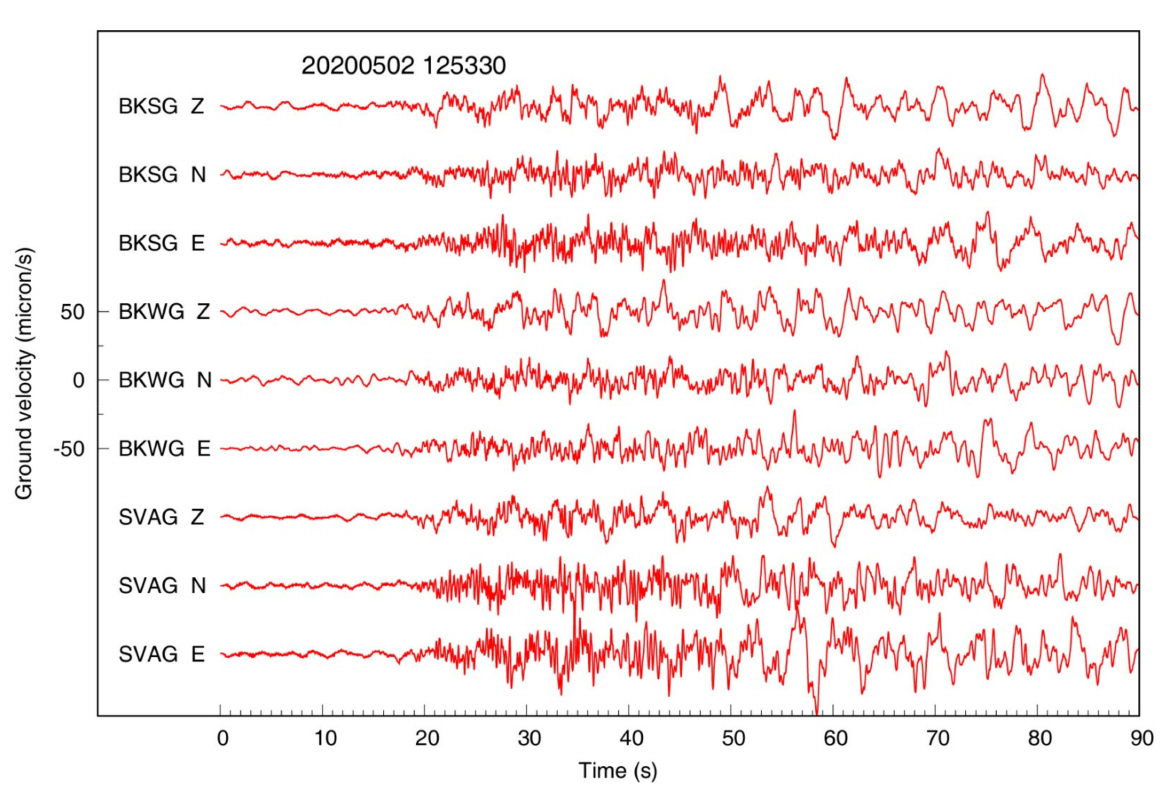
Figure 5. ( a ) Three low-frequency events characterized by low amplitude as recorded at BKSG and BKWG sites. ( b ) Seismograms filtered between 2 Hz and 6 Hz of the first LF earthquake visible in plot ( a ), where it is identified by vertical blue lines.